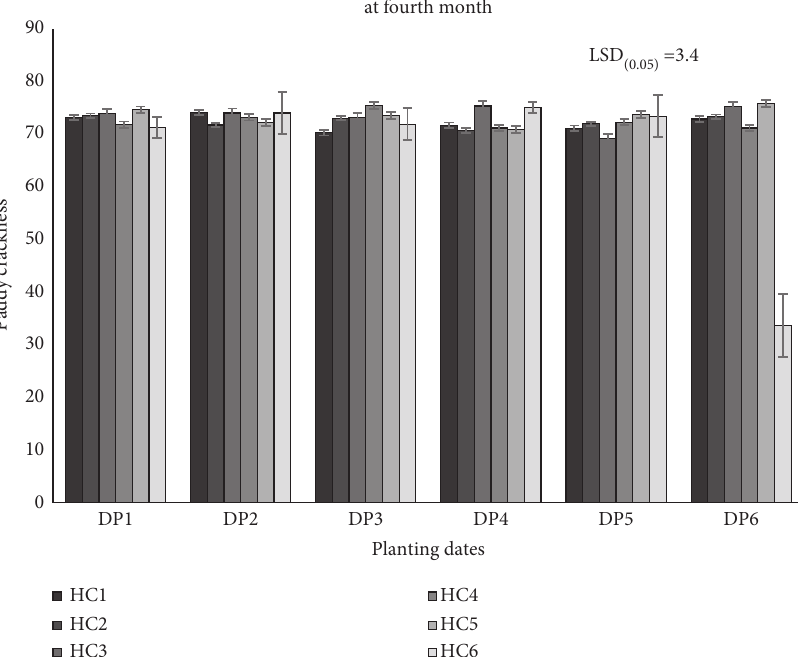
Figure 8: Effect of planting date and harvest cycle on paddy cracking at four months of storage in the Northern Savanna Agroecological Zone of Ghana. Bars represent the SEM. DP1 � first planting, DP2 � second planting, DP3 � third planting, DP4 � fourth planting, DP5 � fifth planting, DP6 � sixth planting, V1 � Agra, V2 � Gbewaa, V3 � Exbaika, V4 � Perfume Irrigated, HC1 � first harvest, HC2 � second harvest, HC3 � third harvest, HC4 � fourth harvest, HC5 � fifth harvest, and HC6 � sixth harvest.